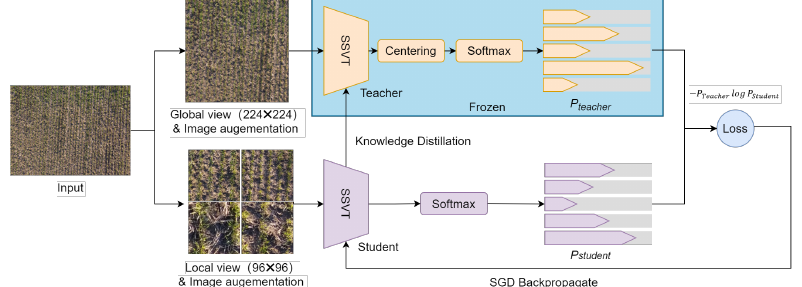
Figure 5. The flowchart of the self-supervised